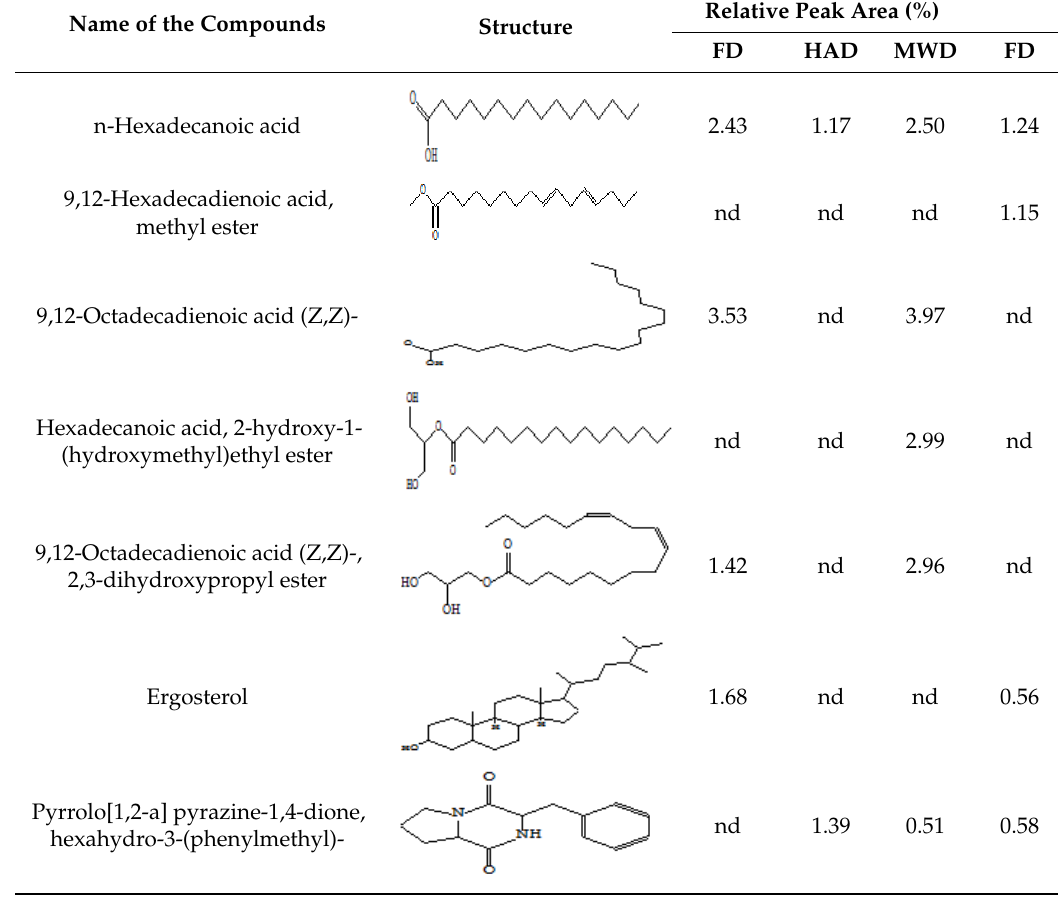
table. FD—freeze drying; HAD—hot air drying; MWD—microwave drying; SD—sun drying. Extracts from dry fruit bodies of Pleurotus ostreatus in simulated gastrointestinal digestion containing more than 50 compounds in the range of 0.22% to 48.62%, identified from the database of